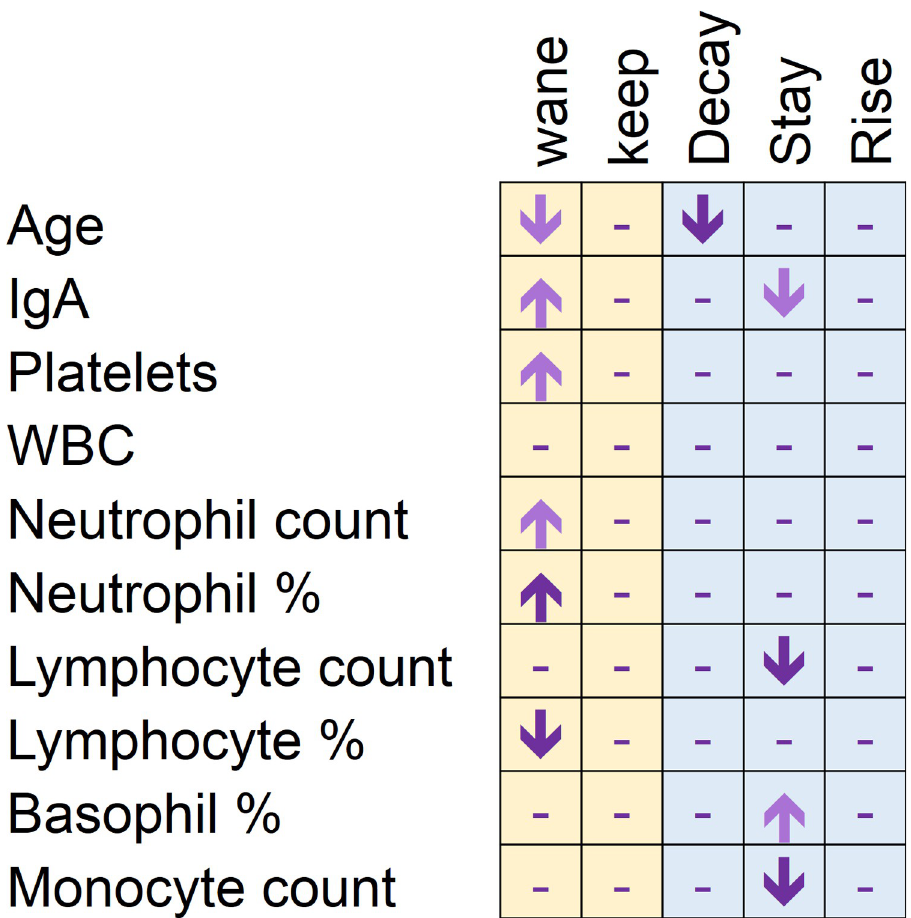
Fig 6. Summary of changes in in anti SARS-CoV-2 total antibodies related to age and hematological parameters. Downshift arrows indicate that low values of the parameter in rows are related to the fact in columns. Wane: Positive donor becomes negative; decay: OD under 90% of the previous one; stay: OD +/-10% of the previous one; rise: OD over 110% of the previous one. Light-coloured arrows represent statistic trends (0.05 < p < 0.2).